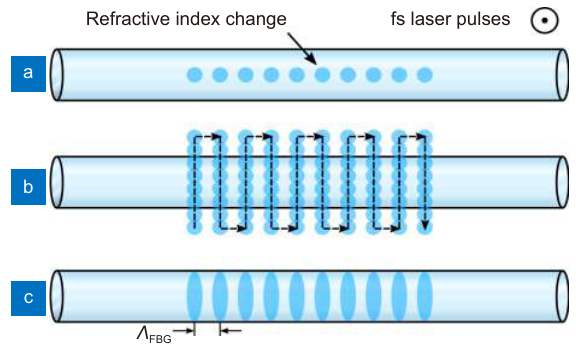
Fig. 3 | Schematic view of an FBG structure induced in the fiber core with different direct fs writing methods. ( a ) Point-by-point method (Gaussian beam). ( b ) Line-by-line method (Gaussian beam with transverse scanning). ( c ) Plane-by-plane method (astigmatic Gaussian